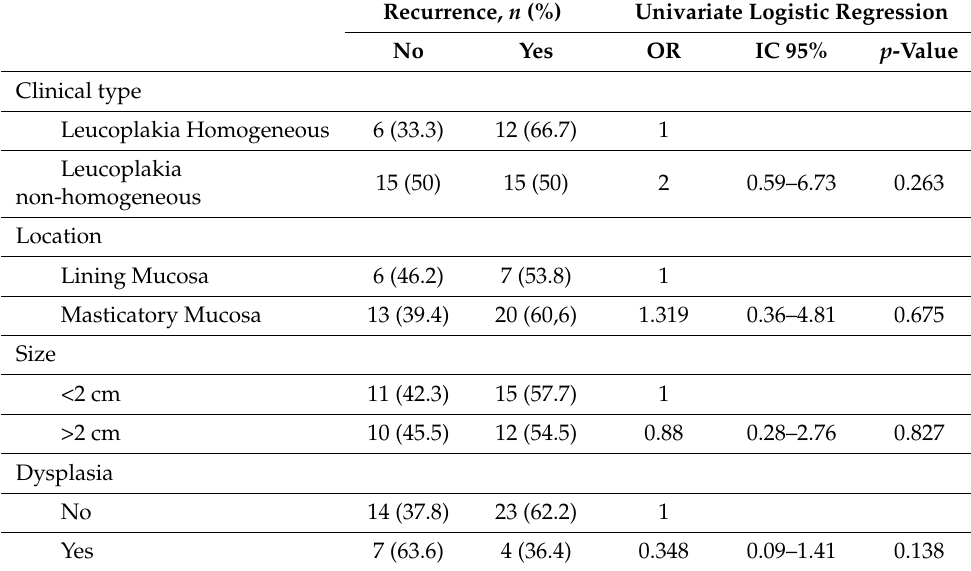
Table 1. CO 2 laser treatment of oral leukoplakia:recurrence.